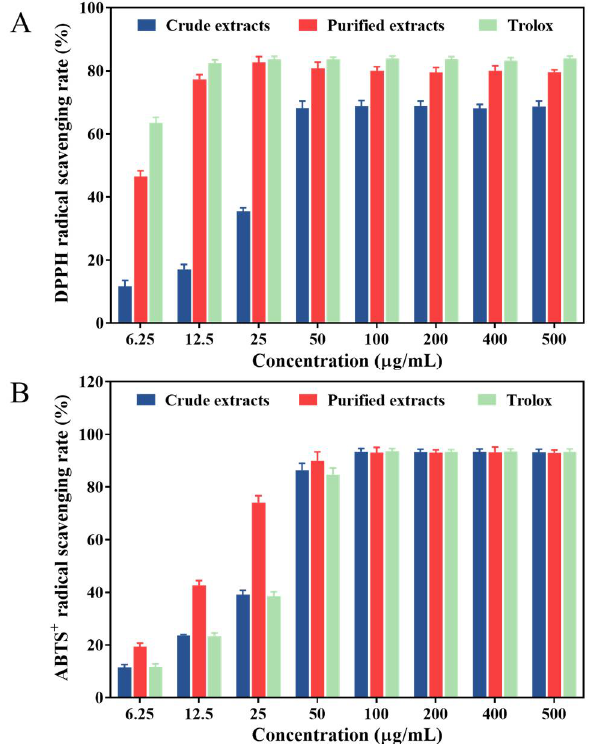
Figure 4. Antioxidant activities of crude and purified extracts in vitro. DPPH• scavenging activity ( A ) and ABTS• + scavenging activity ( B ).